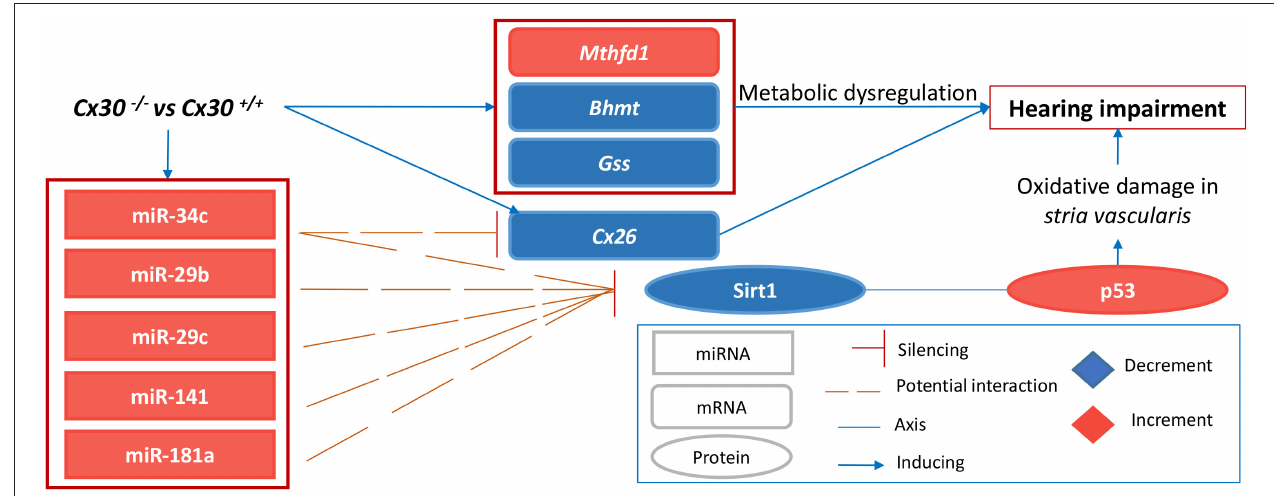
FIGURE 7 | Pathogenic mechanism proposed. The scheme describes our results in a mouse model of inherited digenic deafness at P5, highlighting an early involvement of a miRNA-mediated Sirt1–p53 axis as a nexus between oxidative stress in SV , metabolic dysregulation, and a hearing impairment occurring later in time with vascular dysfunction, which are all hallmarks of